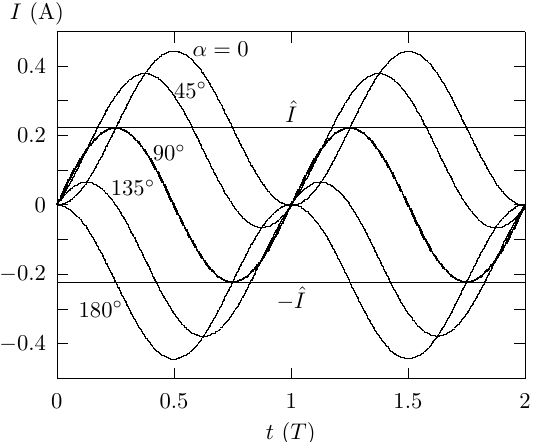
Figure 4. Example 1, f = 1 MHz: The dependence of the current I ( t ) on the initial voltage phase α [ 0,2 T ] for t ∈